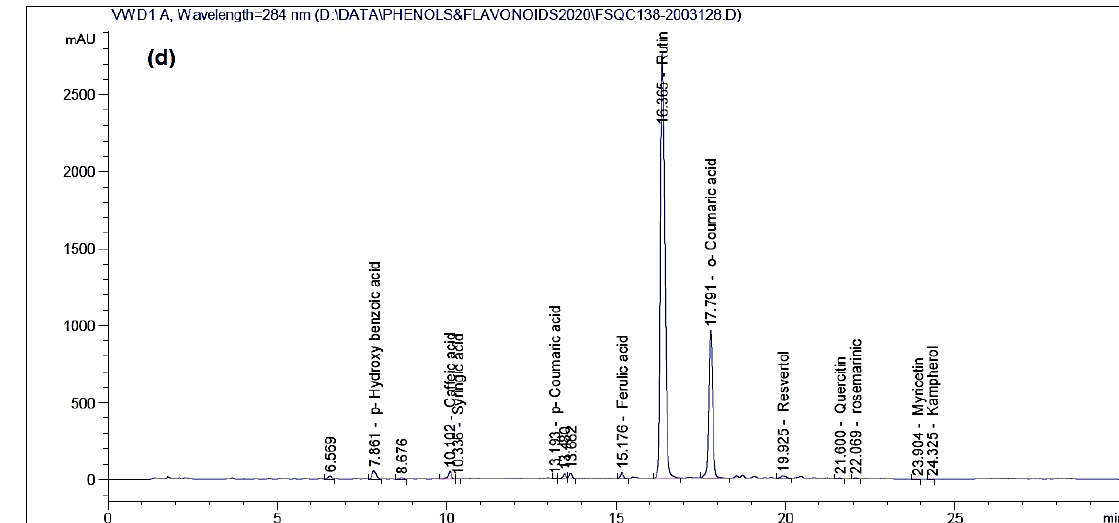
Figure 1. HPLC analysis of extracts from ( a ) Conium maculatum leaves ; ( b ) Acacia saligna bark; ( c ) Schinus terebinthifolius wood; and ( d ) Ficus eriobotryoides leaves.